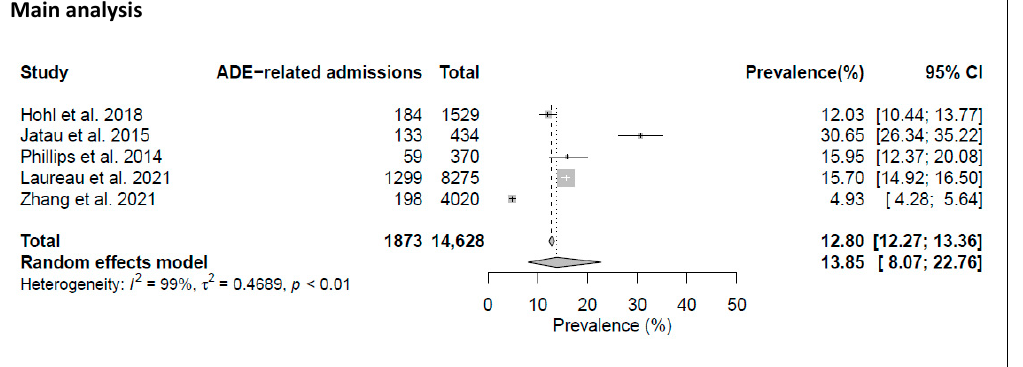
Figure 3. Forest plot of the pooled prevalence of ADE-related admissions to EDs or inpatient wards [35,39,40,42,43].